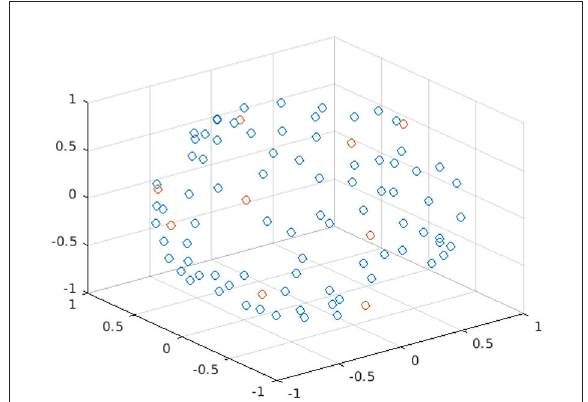
FIGURE1 Plot of the spatial coordinates of the b-vectors for the 90 points of b = 1000 s/mm 2 of the HBP dataset. Each point in the plot represents a different b-vector; the points in red are the b-vectors of one subset selected with Camino.